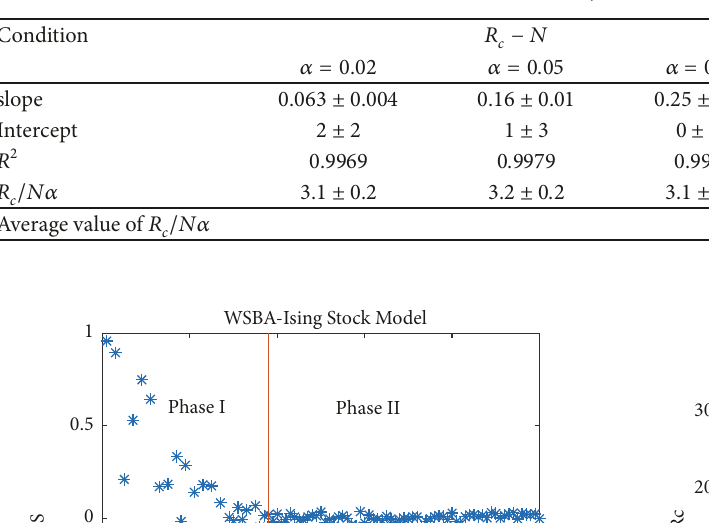
Figure 8: Simulation of the stock sequence with different network configurations. Table 5: Analysis of linear fitting.